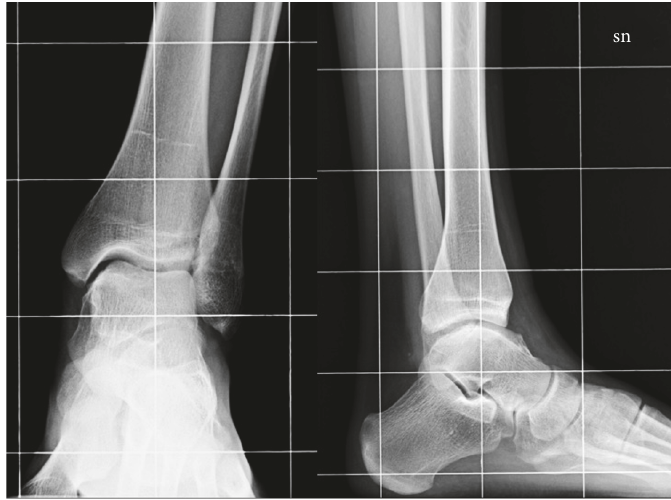
Figure 4: Five-year follow-up X-rays without signs of recurrence or arthritis.